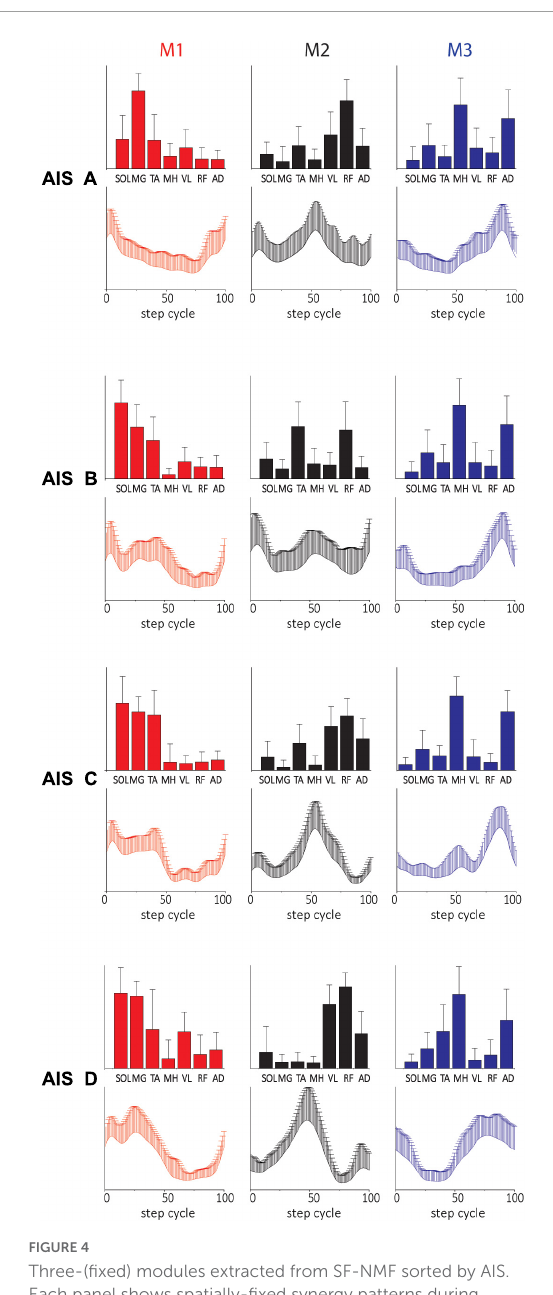
FIGURE4 Three-(fixed) modules extracted from SF-NMF sorted by AIS. Each panel shows spatially-fixed synergy patterns during stepping categorized by AIS grade (group mean + SD). The patterns were generally well correlated across AIS categories. See Table 2 for details on correlation.